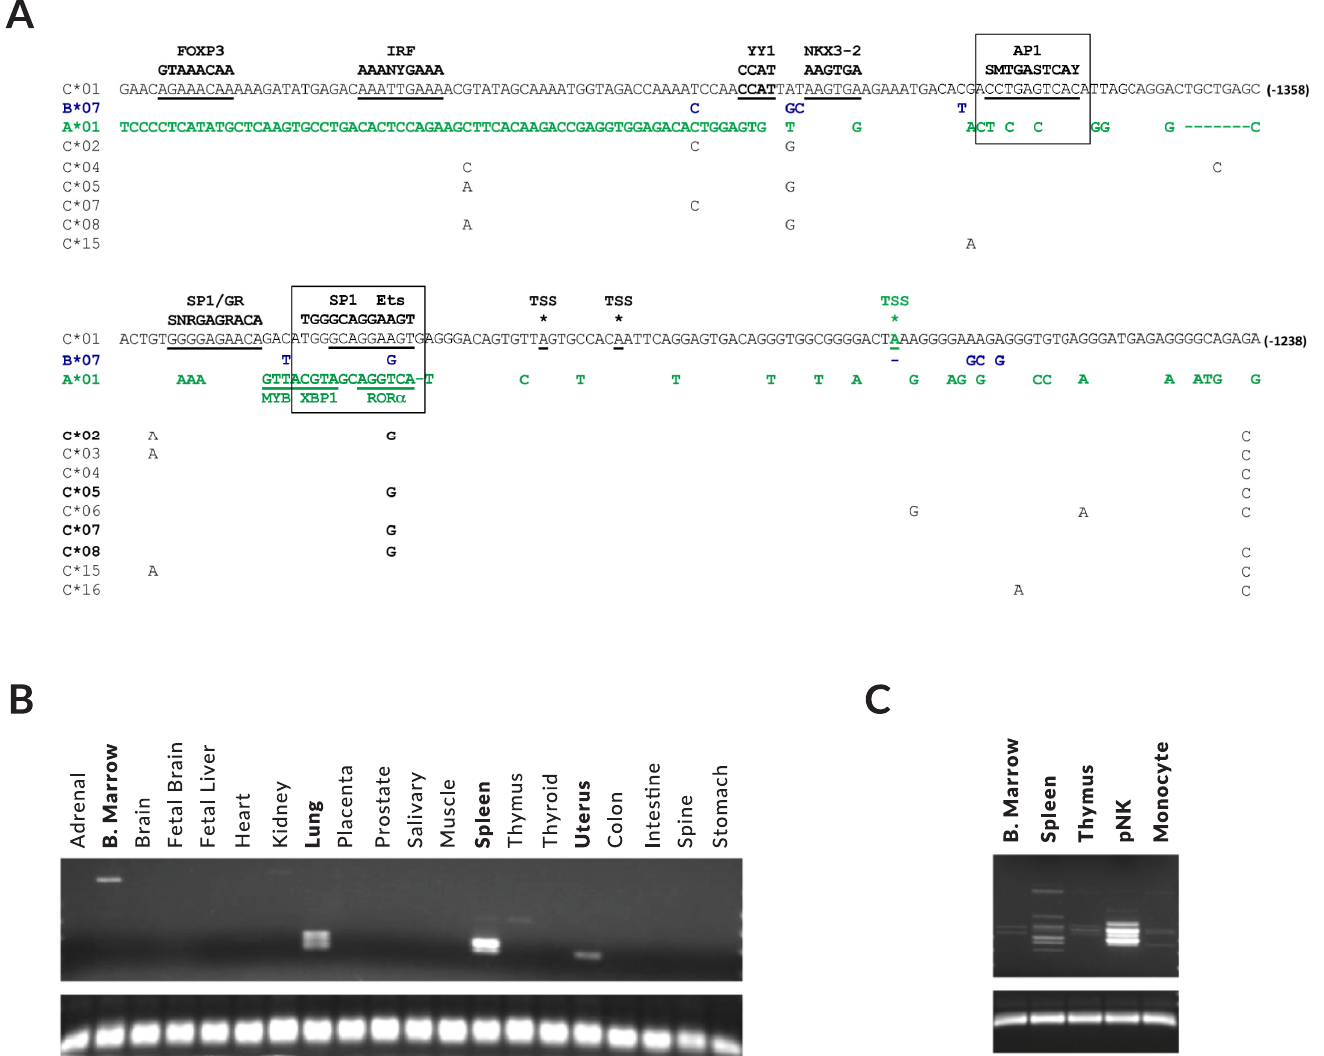
Fig 1. Identification of a promoter element in the -1300 region of the HLA genes. (A) The nucleotide sequence of the HLA-C (cid:3) 01 : 02 gene from -1477 to -1238 upstream of the start codon is shown. Only nucleotide differences are shown in green for HLA-A (cid:3) 01 , in blue for HLA-B (cid:3) 07 , and in black for HLA-C alleles that differ from C (cid:3) 01 : 02 in this region. Predicted TF-binding sites together with their consensus nucleotides are indicated in bold above the C (cid:3) 01 : 02 sequence. The AP1 and combined SP1/Ets1-binding sites are boxed, and distinct TF sites present in the HLA-A gene are shown. The transcription start sites (TSS) of EST clones are indicated by asterisks in black for HLA-C , and in green for HLA-A (B) RT-PCR of a human tissue RNA panel with primers specific for upstream HLA transcripts is shown. Tissues of origin are listed for each lane, with PCR-positive lanes labeled in bold. The lower panel shows an amplicon generated with a primer set from HLA-C exons 7 and 8. (C) PCR of cDNA from purified peripheral blood NK cells (pNK), bone marrow (B. marrow), spleen, thymus, and purified monocytes using HLA-C specific exon-1a and exon 2 reverse primers. The lower panel shows an amplicon generated with a primer set from HLA-C exons 7 and 8.